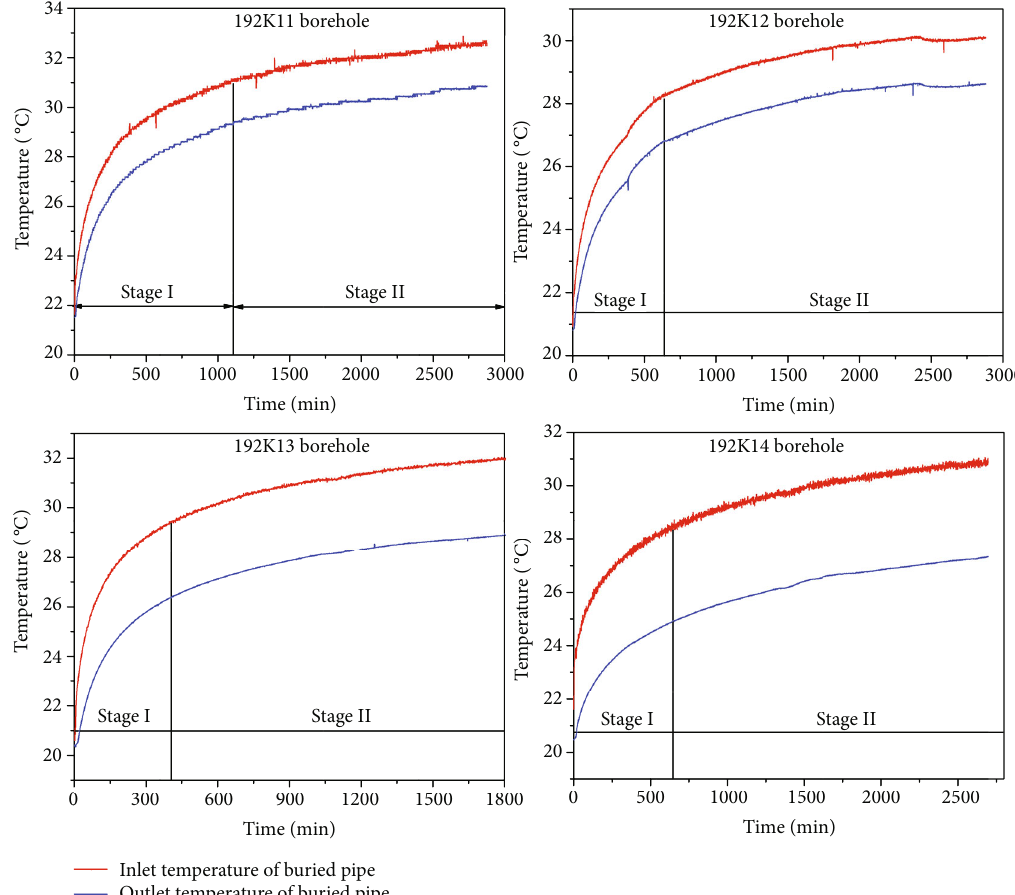
Figure 8: Results of low-power constant heat fl ux test in four geothermal Figure 8. Each temperature measurement curve can be divided into two obvious stages: rapid temperature rise (stage I) and stable temperature (stage II). Stage I is in the fi rst ten hours of the test, the temperature at the inlet and outlet of the buried pipe changes rapidly, and the tempera- ture in the borehole (back fi ll material) rises rapidly. Stage II shows that the temperature change in the borehole decreases with the heating time, which can be regarded as a steady-state heat conduction process.